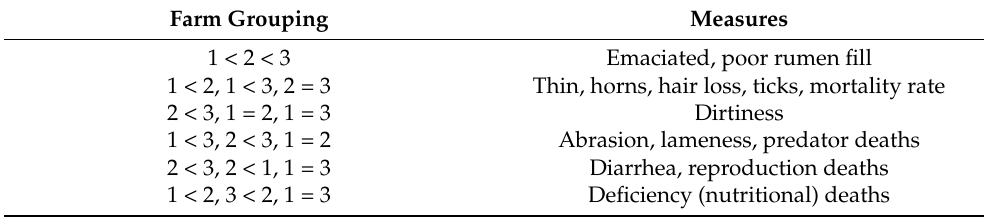
Table 3. Groupings by farm category (1: Commercial ( n = 17), 2: Semi-commercial ( n = 20), 3: Com- munal ( n = 18)), using the Dunn test (with Holm-Bonferroni correction for multiple comparisons)). Farm